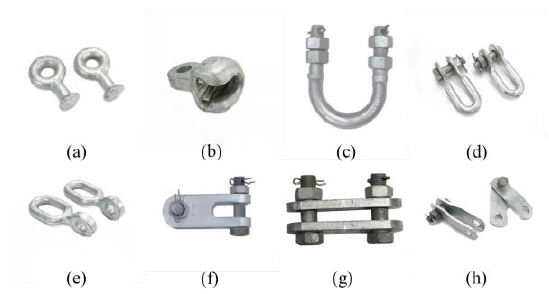
Figure 2 . Link fittings: (a) ball eye, (b) socket-clevis eye, (c) U- bolt, (d) shackle, (e) eye chain links, (f) clevis, (g) yoke plate (type P), and (h) yoke plate (type PS).